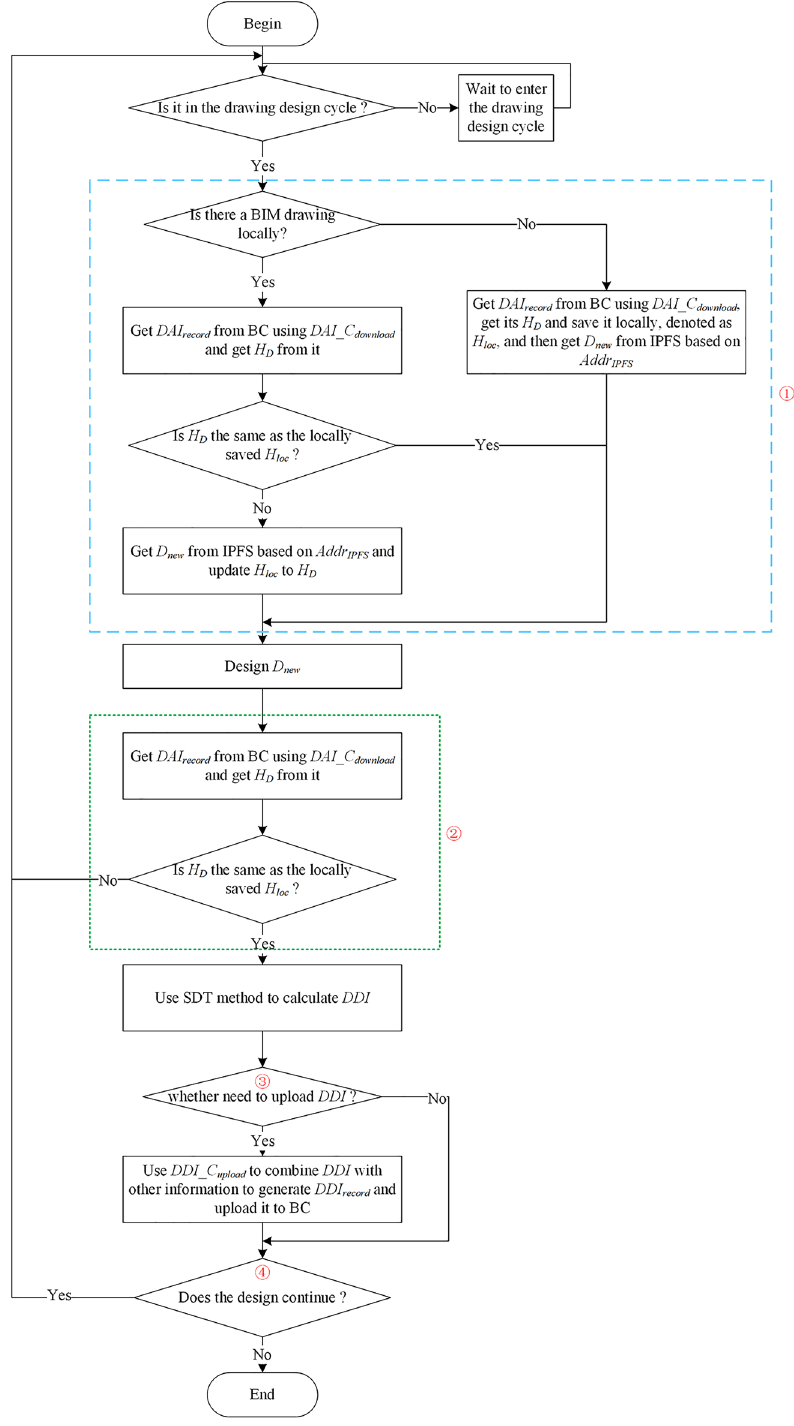
Figure 8. The operation process of BIM drawing